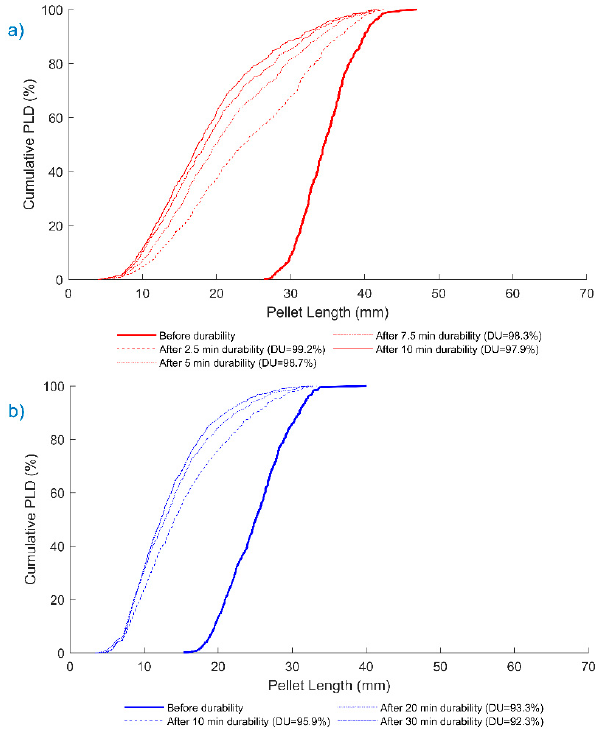
Figure 10. Pellet length distributions of ( a ) torrefied mixed wood and ( b ) raw miscanthus before and ff erent mechanical durability tests (DU: mechanical after different mechanical durability tests (DU: mechanical durability). after di